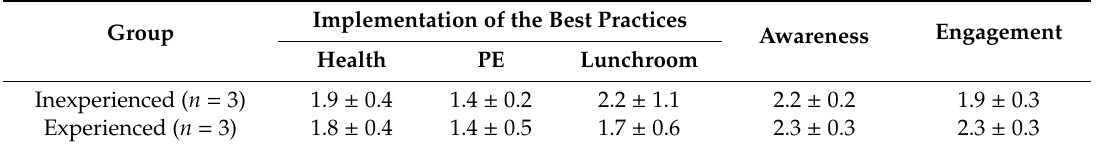
Table 2. Whole-of-School Implementation Outcomes for Best Practices, Awareness, and Engagement (M ±